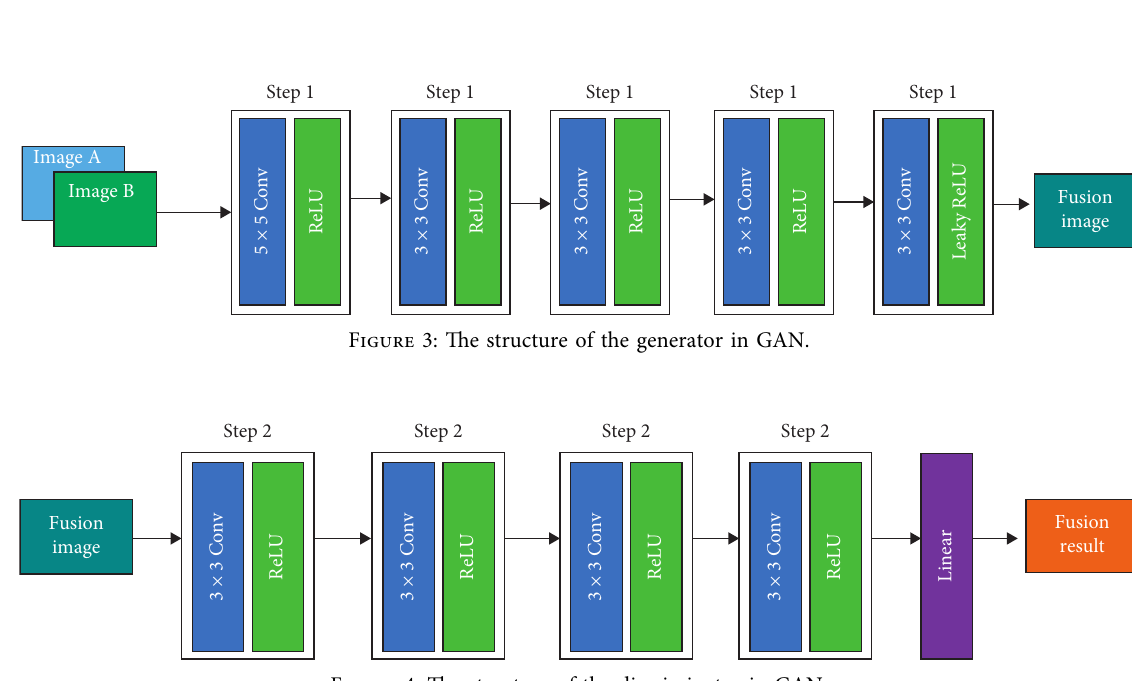
Figure 2: An example of the complex shearlet transformation.